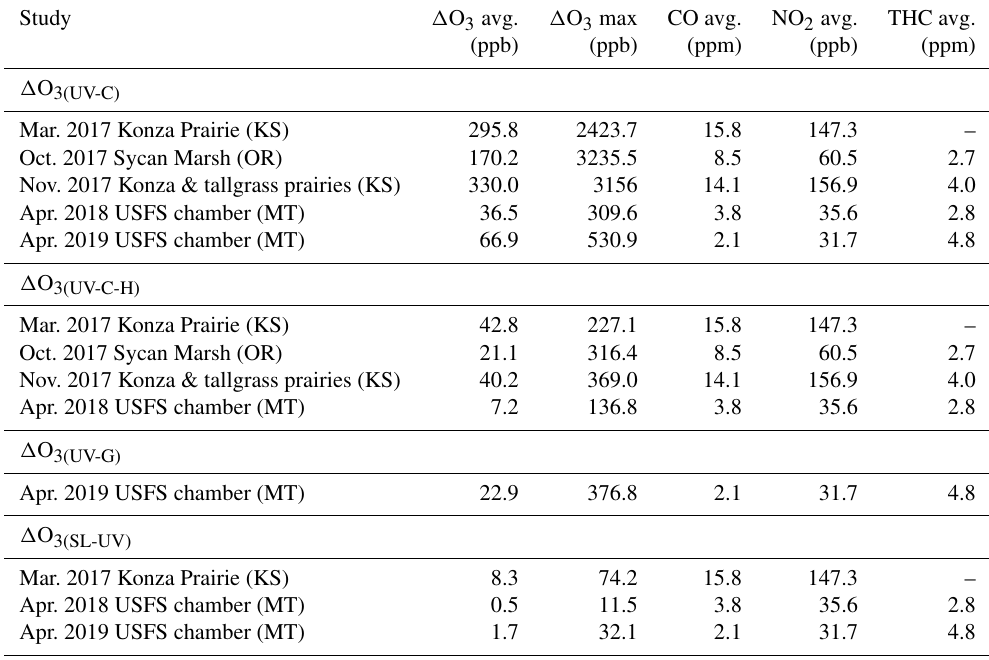
Table 3. Ozone artifact ( (cid:49) O 3 ) averages, maximum values, and CO, NO 2 , and THC averages from the prescribed fire and USFS chamber burns as measured by the UV-C, UV-C-H, and UV-G instruments. Study (cid:49) O 3